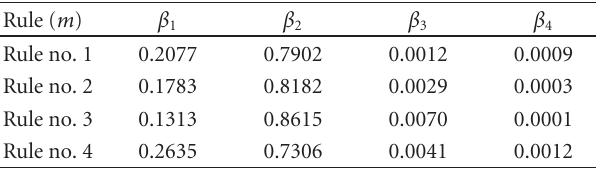
Table 5: Estimated β coe ffi cients.